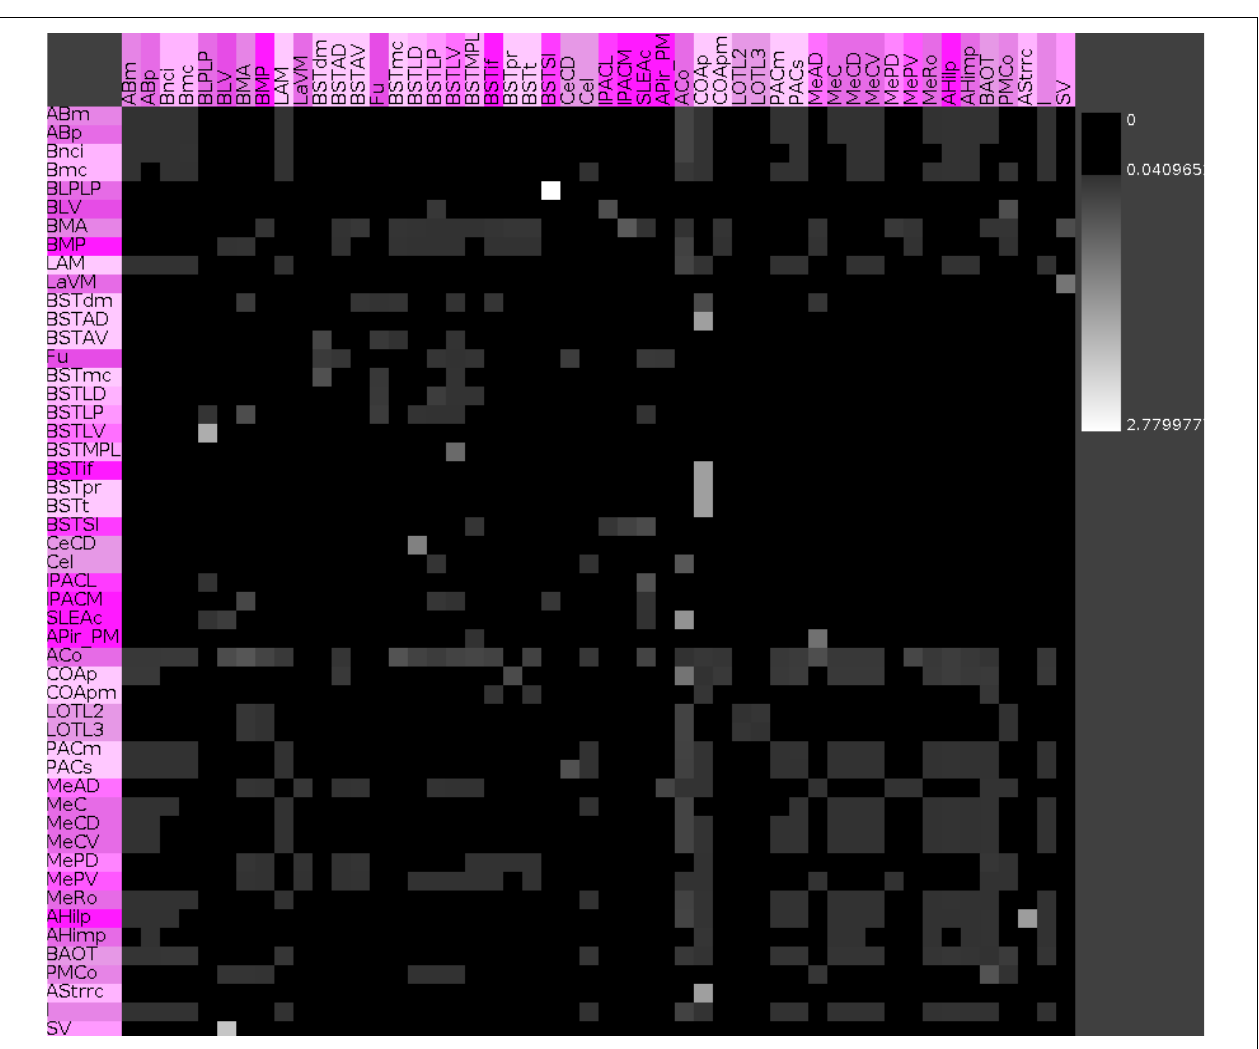
basolateral nucleus lateral part to the supracapsular bed nucleus of the stria terminalis lateral part has the largest significance of 2.78% (lightest gray